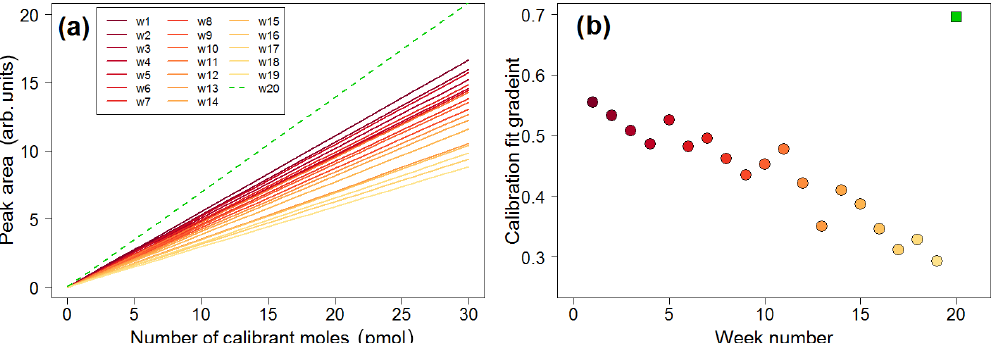
Figure 16. (a) Calibration lines plotted in weekly intervals, showing decreasing sensitivity over time (solid lines). The green dashed line is the calibration plot obtained once the trap was replaced. (b) Time series of the gradients of the calibration plots showing decreasing sensitivity (filled circles). The green square represents the calibration plot gradient obtained after replacing the